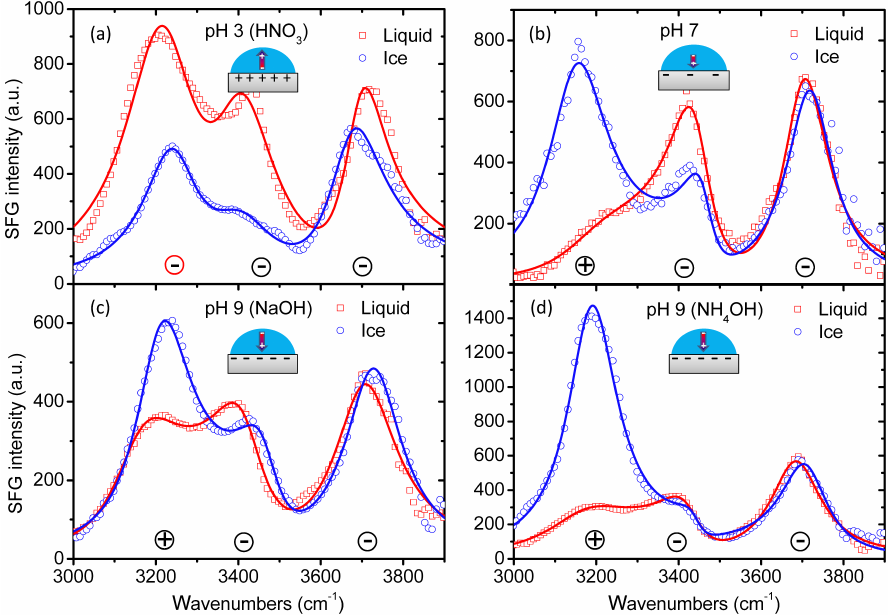
Figure 3. Measured (points) and fitted (lines) SFG spectra of α -Al 2 O 3 (0001)–water interfaces collected in SSP polarization during the cooling cycles of (a) pH 3 – HNO 3 , (b) pH 7, (c) pH 9 – NaOH, and (d) pH 9 – NH 4 OH. The spectra shown here are always the last and first spectrum right before (red) and immediately after (blue) the freezing event, respectively. The signs of the resonances are indicated by a circle with + or − sign (see Supplement for details). The insets in (a) , (b) , (c) , and (d) illustrate the net dipole orientations (from O to H, as inferred from the low-frequency peak) of water on the surface at different pHs (surface